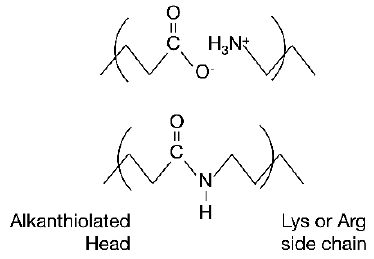
Scheme 1. Schematic representation of the different strategies that were employed for SLAC immobilization. Upper panel: electrostatic interaction. Lower panel: covalent immobilization via formation of amide bond.